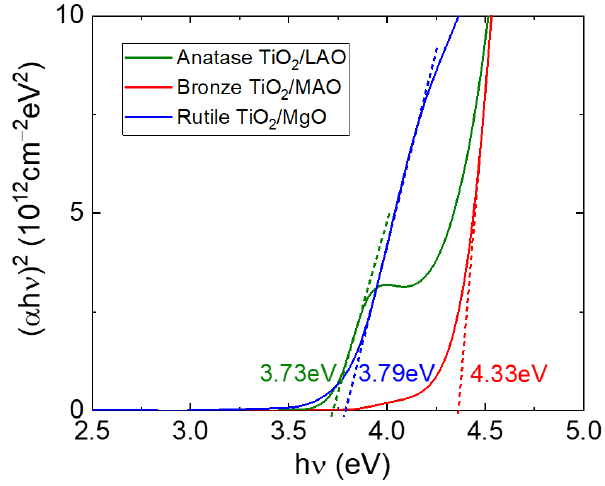
Figure 5. Tauc plot of the absorption coefficient α as function of the photon energy h v for the single- layer TiO 2 films. The band gaps were determined by extrapolating the linear parts of the curves to zero. A clear difference between the bronze film and the other polymorphs can be